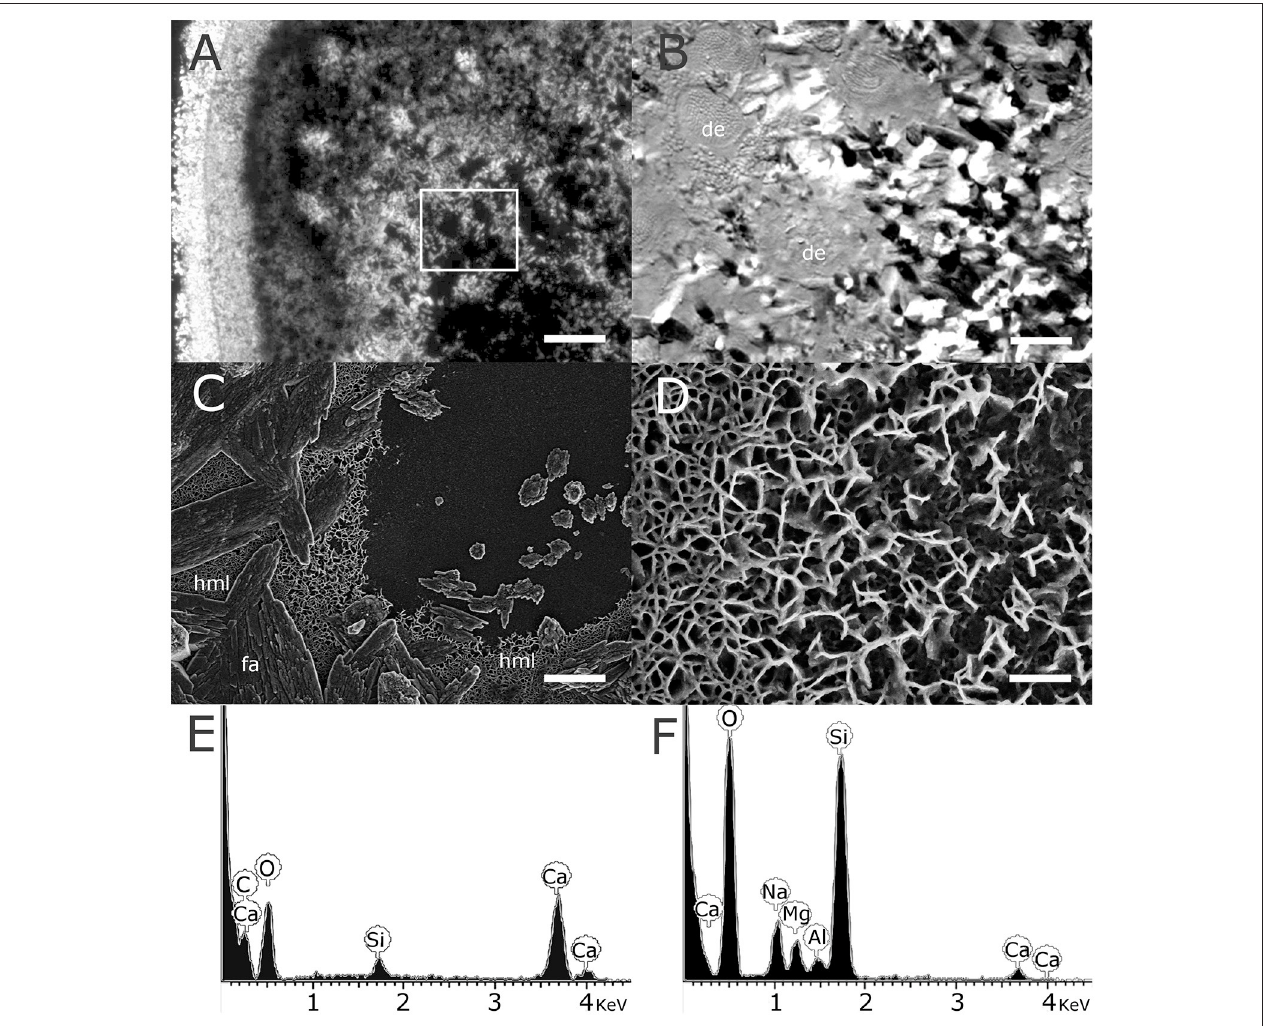
FIGURE 2 | High magnesium lattice deposited by the coral precedes the precipitation of fibrous aragonite. (A) Polarized light microscopy showing the basal plate of a live micropropagate 2 weeks following settlement, with clayx edge to the left. Scale − 100 µ m. (B) Differential interference contrast microscopy showing high magnification of the region denoted by the white rectangle in (A) . Gaps between the aragonite fibers forming the basal plate where often associated with round or oval desmoidal cells (de) with a typical diameter of 20 µ m attaching the coral tissue to the glass substrate. Scale − 20 µ m. (C) High resolution SEM showing details of the basal plate of a micropropagate, showing fibrous aragonite (fa) overlaying a high magnesium lattice (hml) deposited on the glass substrate. Scale − 3 µ m. (D) High magnification of the hml revealing a nanometer scale lamellar structure. Scale − 0.5 µ m. (E,F) —EDS analysis of the fibrous aragonite and lattice structures seen in (C), showing low calcium and high magnesium levels in the hml (sodium and silica signals are likely derived from the glass